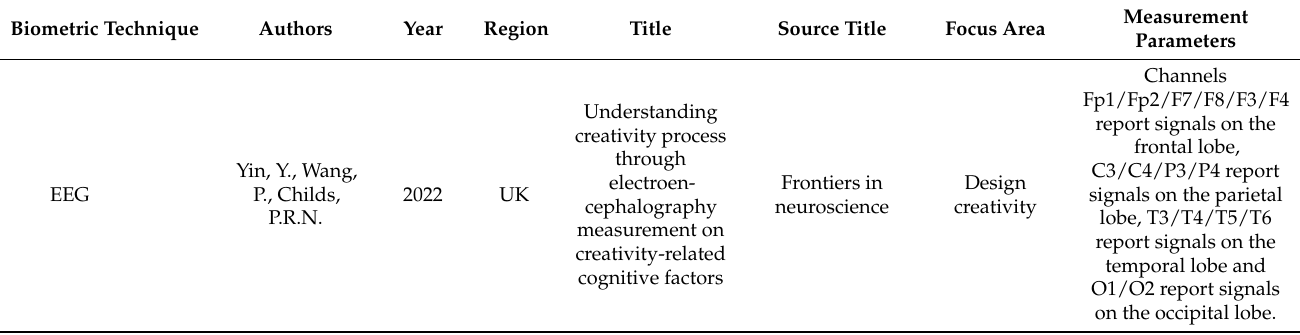
Table 1. Review articles on biometric analysis in design cognition.